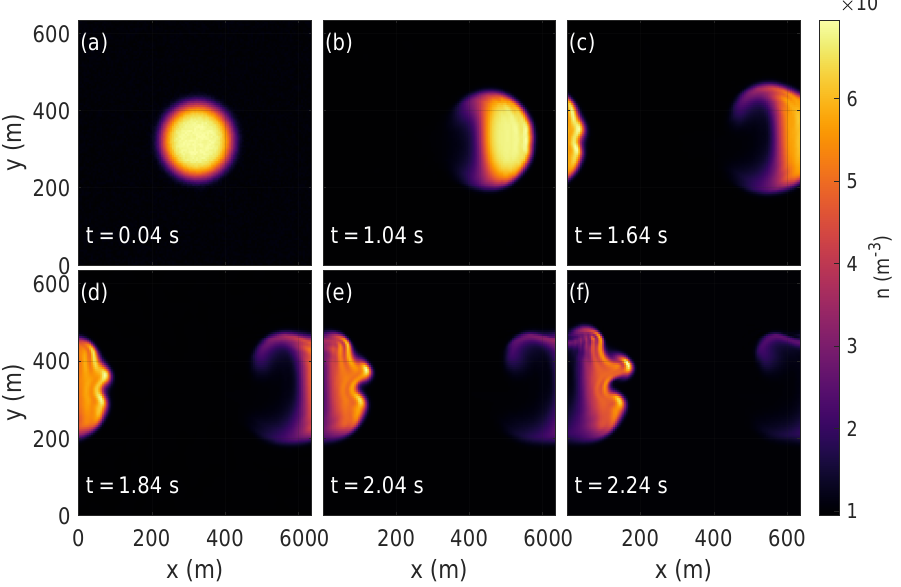
Figure 7. Density color plots of 2D slices at the mid-plane of ˆ z showing the evolution of a 3D plasma enhancement cloud simulation in a collisional regime. Panel ( a ) shows the initial cloud. Panel ( b ) shows the cloud then begins to move to the right, with the trailing edges slightly rolling up. In panels ( d , e ), a bifurcation begins as a finger-like structure extends from the plasma cloud. In Panel ( f ), the tip of the finger-like structure curls into itself, forming a secondary KHI.